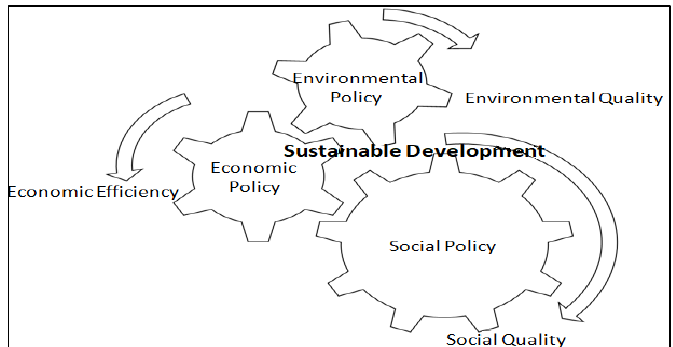
Figure 2: Interconnection of the three dimensions of sustainable